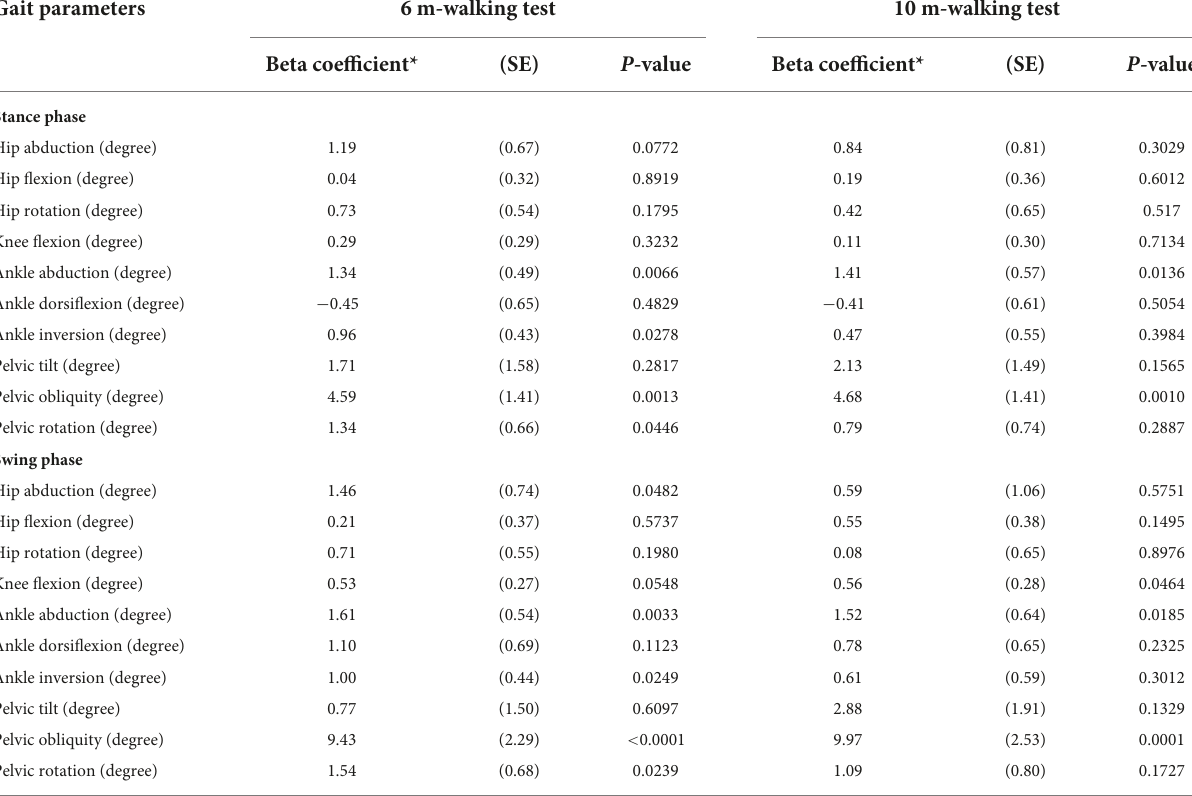
TABLE 4 Results from the linear regression models: beta coefficients (SE)* for SNSB-C score percentile, associated with gait parameters. Gait